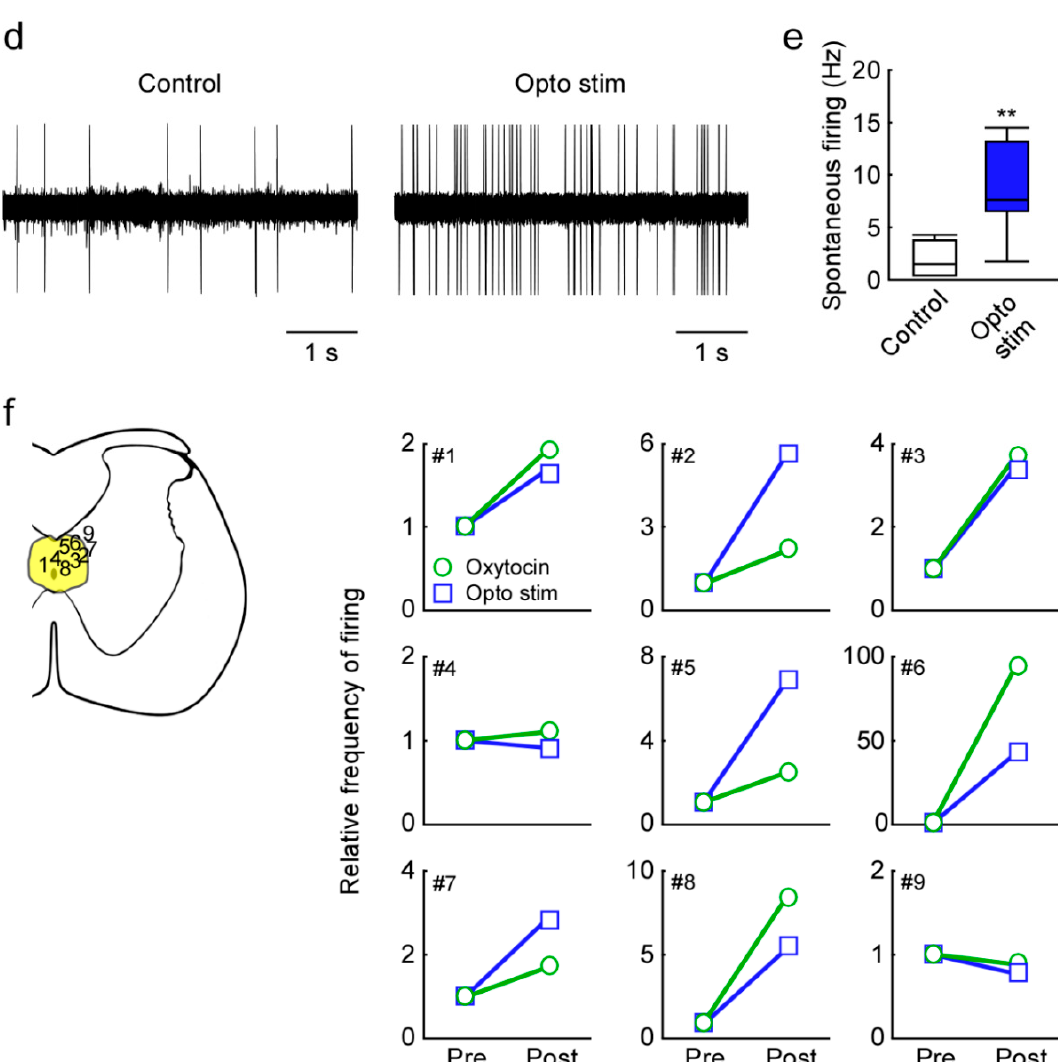
Figure 4. In vivo extracellular recordings from lamina X oxytocin-responsive neurons in the upper lumbar spinal cord (L3–L4 level) after superfusion of oxytocin or optogenetic stimulation of the paraventricular nucleus of the hypothalamus (PVH) of Oxtr -ChR2-EYFP transgenic rats. ( a ) Schematic drawing of the brain–spinal cord neural network controlling male sexual function and the location of optogenetic stimulation. The oxytocin neurons, expressing channel rhodopsin (ChR2; green) in the paraventricular nucleus of the hypothalamus project to the upper lumbar spinal cord (L3–L4 level) and act on the lamina X oxytocin-responsive neurons (magenta). ( b ) In vivo electrophysiology revealed that oxytocin-responsive neuronal firing was increased by oxytocin superfusion (1 µ M) compared to control. ( c ) Quantification analysis showed that spontaneous firing was increased after oxytocin superfusion compared with control (the boxes show the 25th to 75th percentiles and the median, n = 9; paired t -test, * p < 0.05). ( d ) In vivo electrophysiology revealed that the frequency of oxytocin-responsive neuronal firing was significantly increased by the optogenetic stimulation of PVH when compared with control. ( e ) Quantification analysis showed that spontaneous firing was increased after optogenetic stimulation compared with control (the boxes show the 25th to 75th percentiles and the median, n = 7; paired t -test, ** p < 0.01). ( b , d ) were recorded from the same neuron. ( f ) Responsiveness of superfusion of oxytocin or optogenetic stimulation on spontaneous firing from lamina X neurons. (Left) Summary of recording depth on each neuron (plotted by numbers: 1–9). (Right) Summary showing effect of oxytocin or optogenetic stimulation on the relative frequency of firing in lamina X